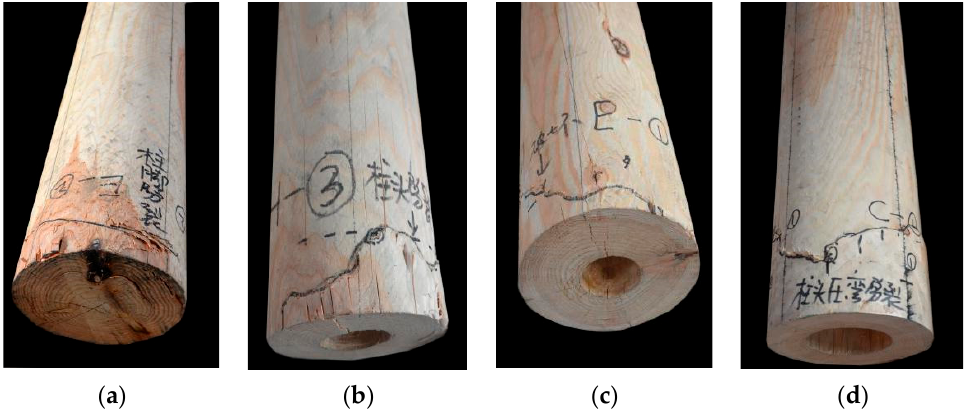
Figure 16. Load failure mode of central cavity: ( a ) The rising of local fibers; ( b ) Vertical cracks; ( c ) Ring cracks along the direction of the annual rings; ( d ) Wrinkes.